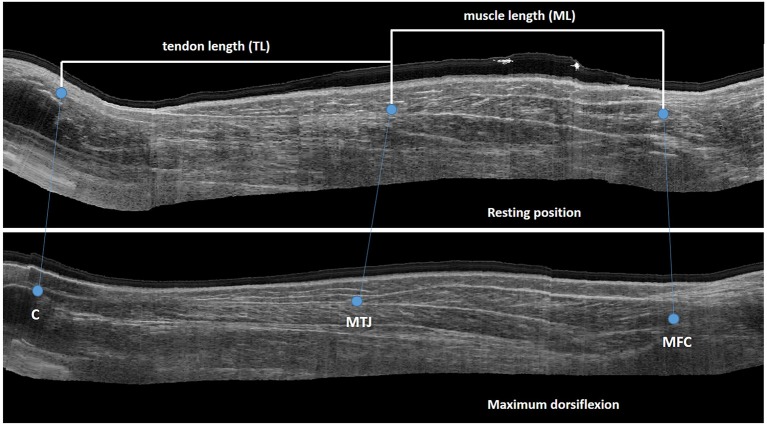
Sagittal US image with landmarks for extraction of muscle and tendon length C, calcaneus; MTJ, muscle tendon junction; MFC, medial femoral condyle.